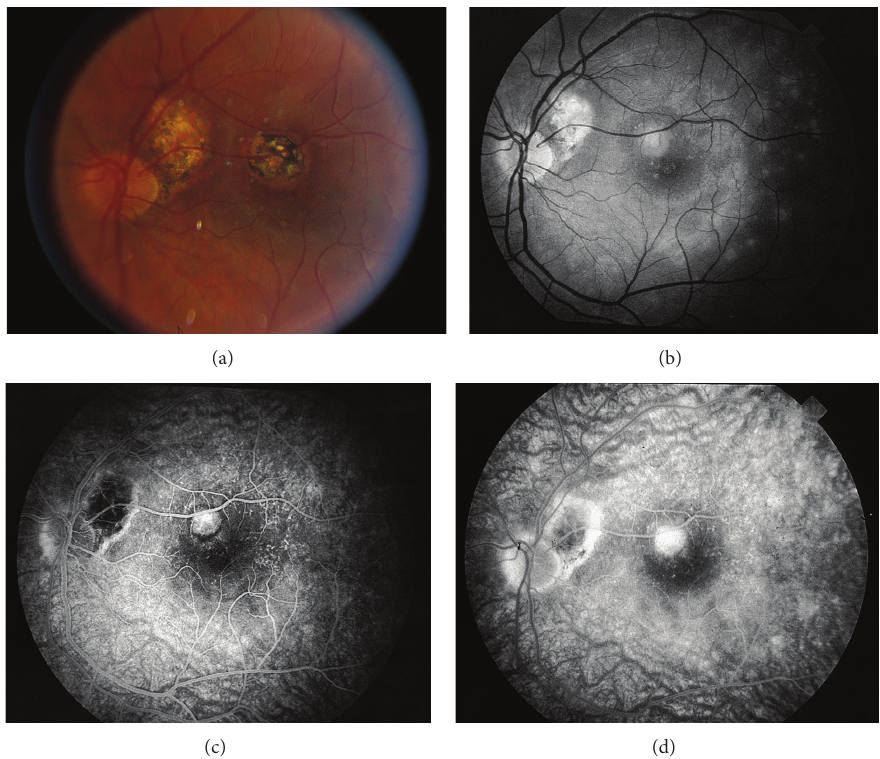
Figure 5: (a) Fundus photography and corresponding fluorescein angiogram ((b)–(d)) of a young woman with PIC demonstrating leakage consistent with a choroidal neovascular membrane.